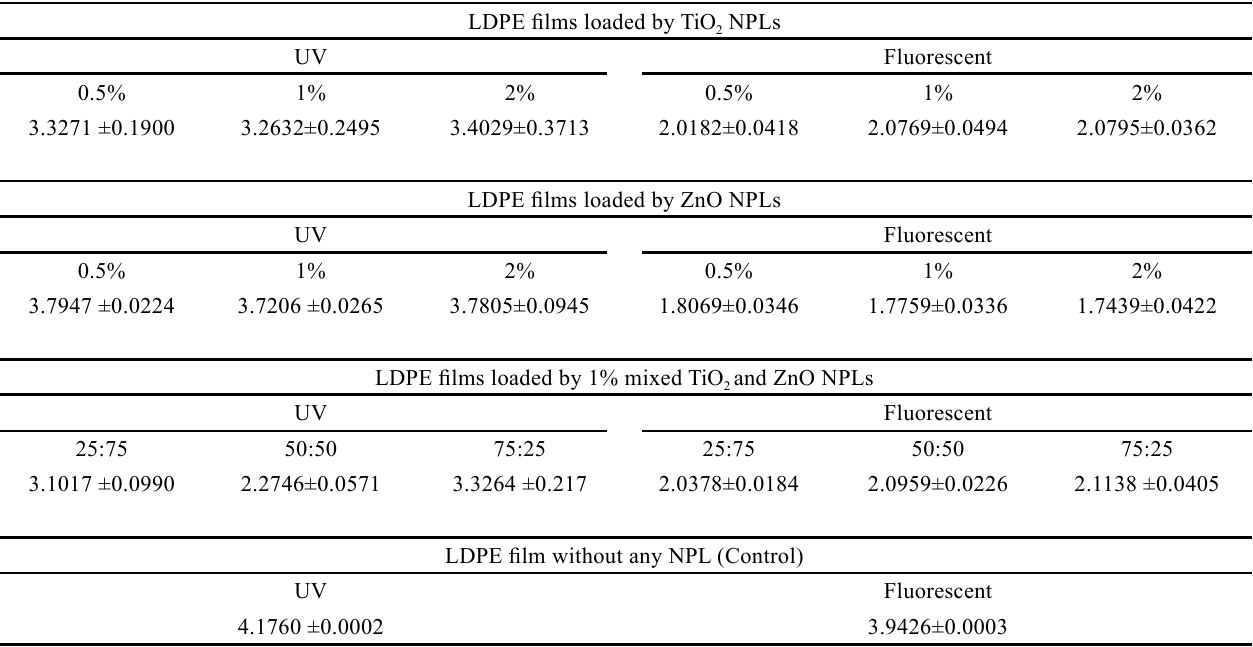
T able 2. The mean values of S. aureus colony counts (log CFU/g) for fresh calf minced meat packed in LDPE films loaded by various dosages of ZnO and TiO 2 NPLs after 72 hr exposed under fluorescent and UV light at 4 o